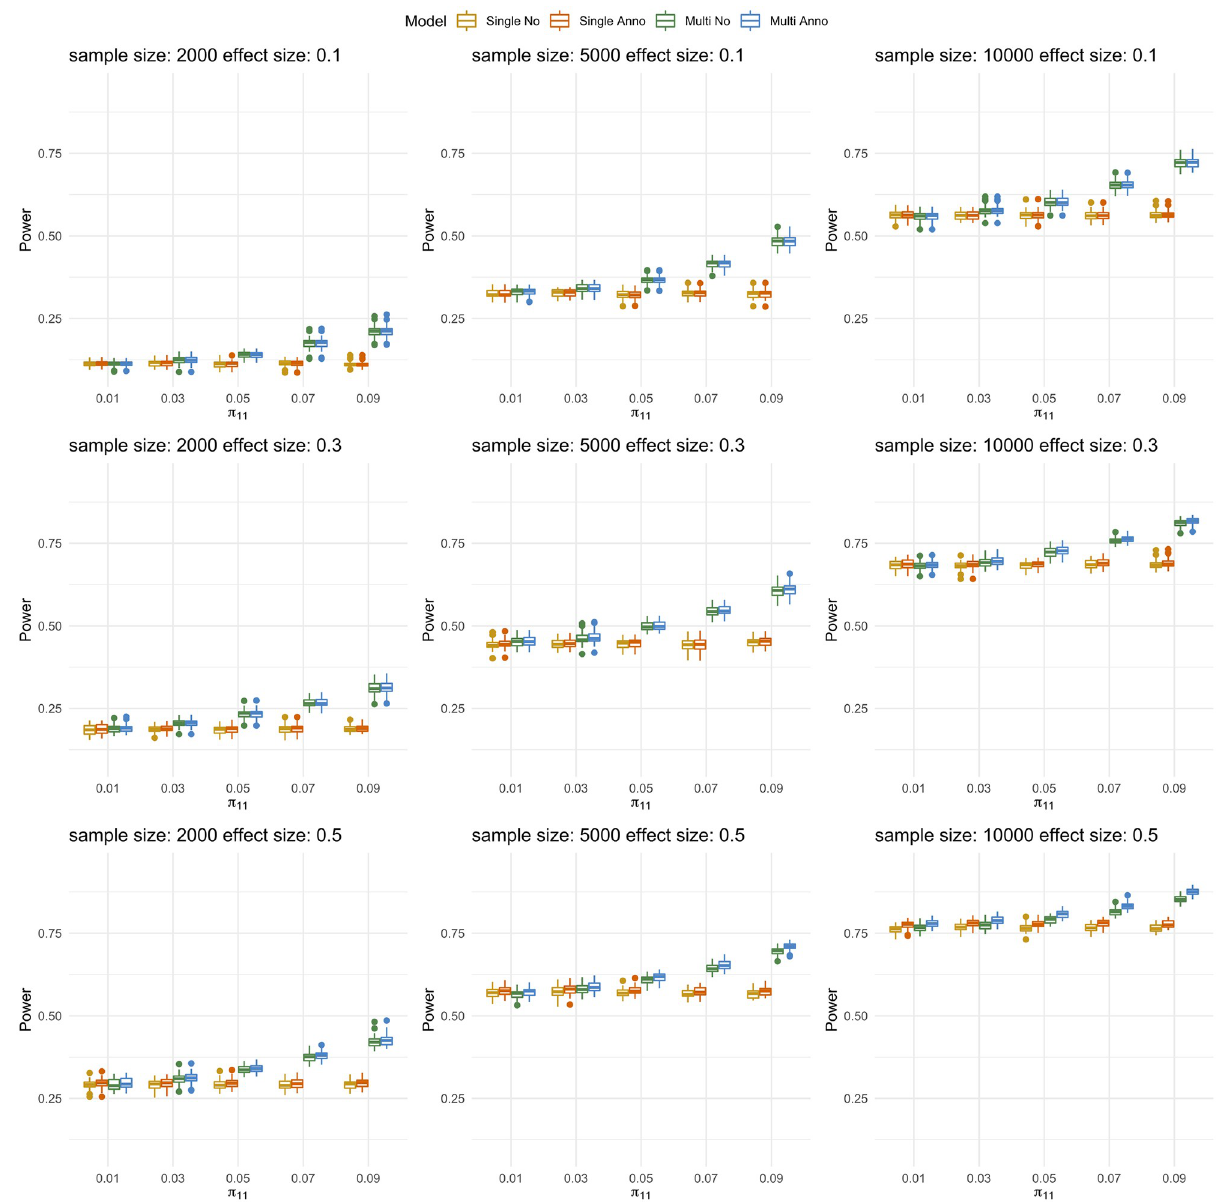
Fig 2. Power performance under different strengths of annotations. The panels from top to bottom show the power performance under weak, moderate and strong annotations, respectively. For each panel, each plot from left to right represents study sample size of 2000, 5000, and 10000, respectively. Within each plot, boxes from left to right represent the proportion of shared risk genes being 0.01, 0.03, 0.05, 0.07 and 0.09, respectively. Each scenario is replicated for 50 times in our